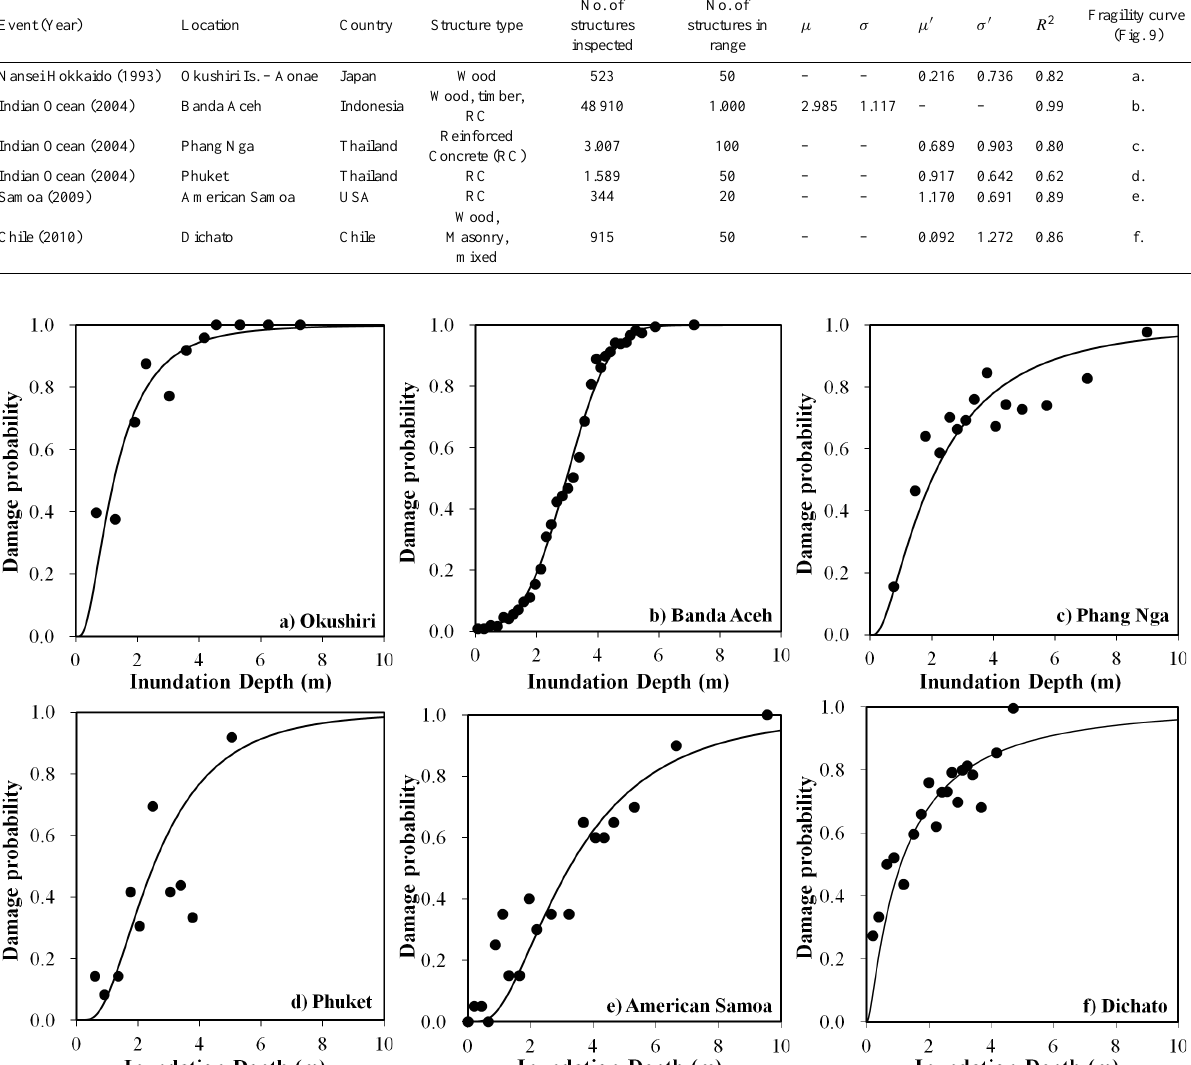
Table 2. Summary of statistical parameters for developed fragility curves (modified from Suppasri et al., 2012a). The parameters µ and σ are the mean and standard deviations of the normal distribution, while µ 0 and σ 0 are similar parameters in a standardized lognormal distribution.